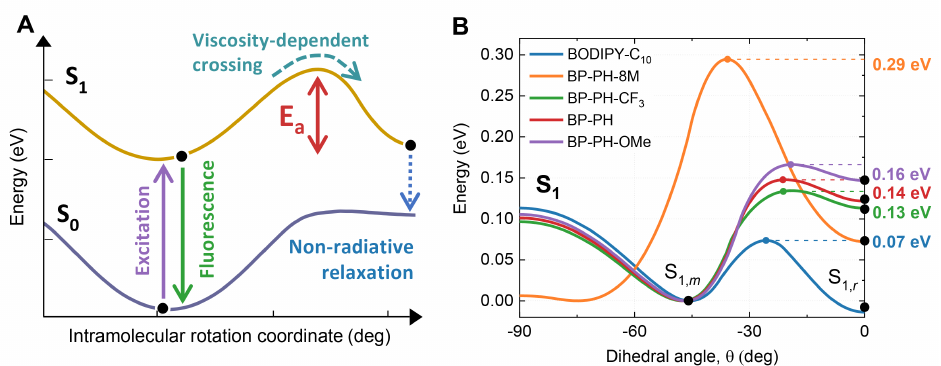
Figure 3. ( A ) Theoretical model of deexcitation pathways in BODIPY-based molecular rotors. ( B ) Po- tential energy surface curves of the first excited electronic state (S 1 ) of BODIPY-C 10 (blue), BP-PH-8M (orange), BP-PH-CF 3 (green), BP-PH (red), and BP-PH-OMe (purple) calculated using DFT. θ is a dihedral angle between the BODIPY core and the meso -phenyl group. The S 1,m minima of curves were set to 0 for easier